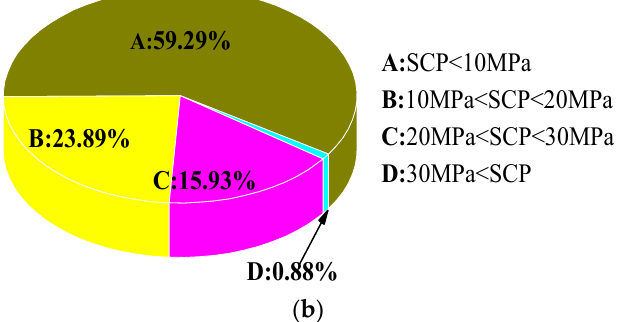
Figure 1. The sustained casing pressure in shale gas wells: ( a ) the percentage of wells with SCP during the whole life time of wells; ( b ) the percentage of the different SCP in wells.